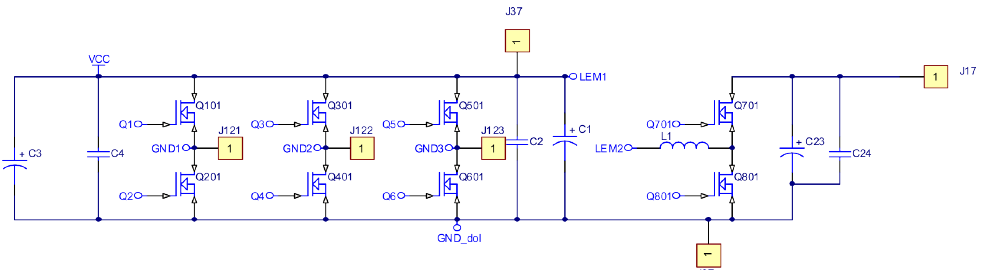
Figure 16. Schematic diagram of the power elements of the electronic commutator bridge and DC/DC